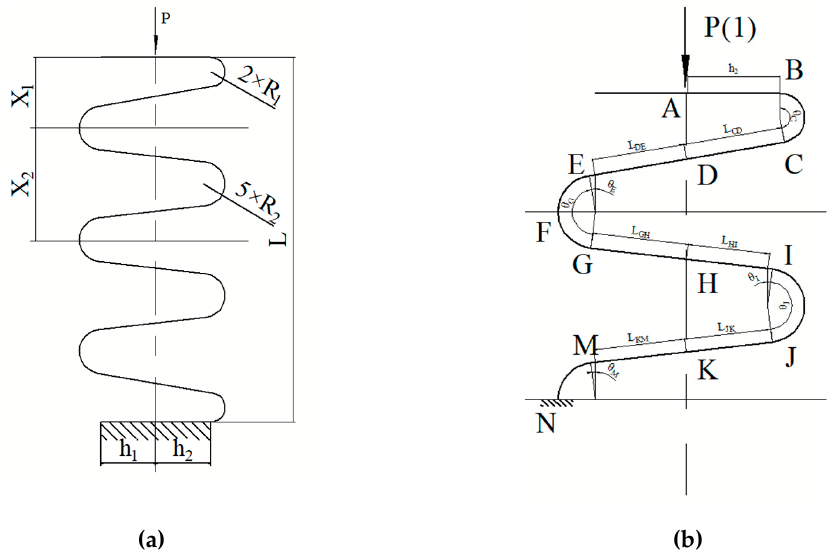
Figure 4. Force analysis of GFRP wave spring. ( a ) Schematic diagrams of composite wave spring, ( b ) Force analysis of single-period composite wave spring.